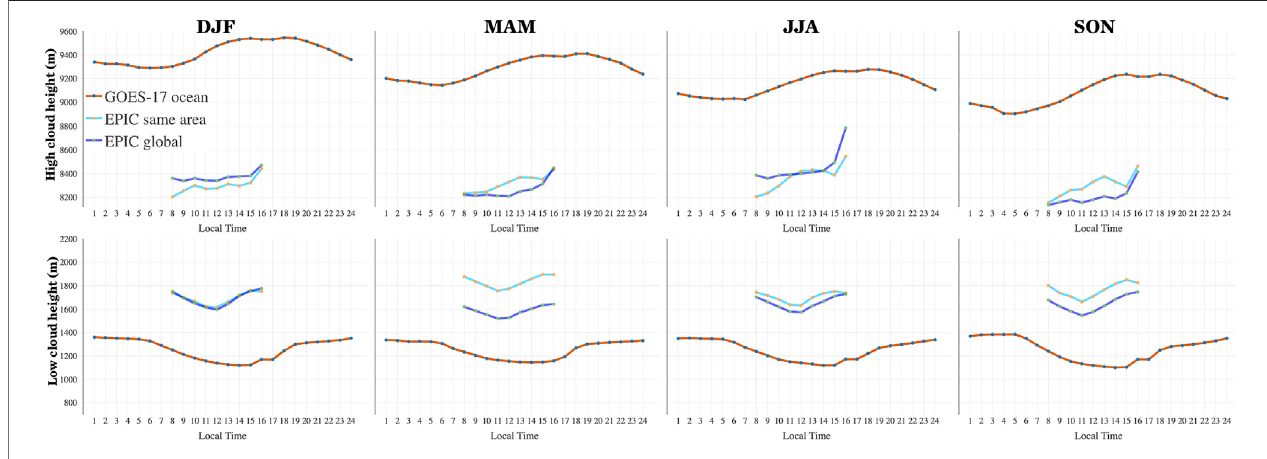
FIGURE 3 | As Figure 2 , but for GOES-17 over